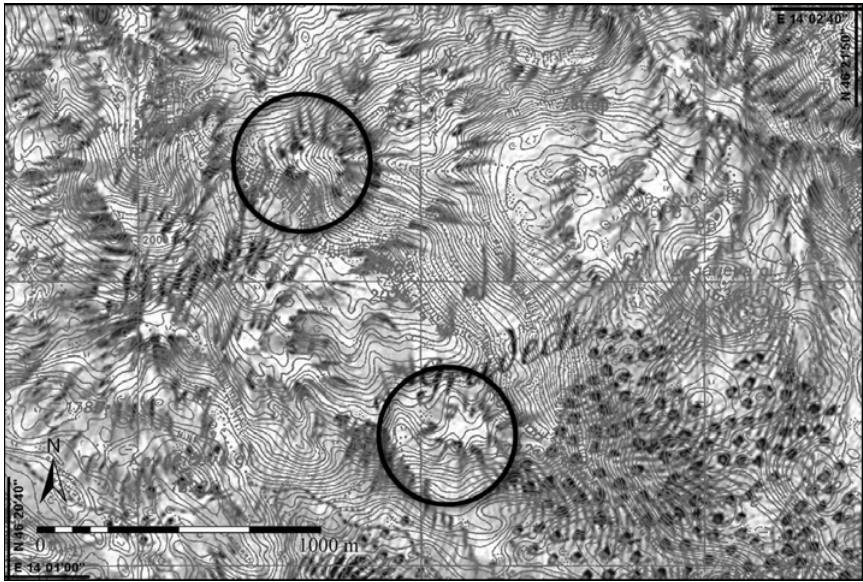
Figure 2. The evident discrepancy in the position of peaks between old (hatched) and modern (contour lines) maps (for the plateau Pokljuka).